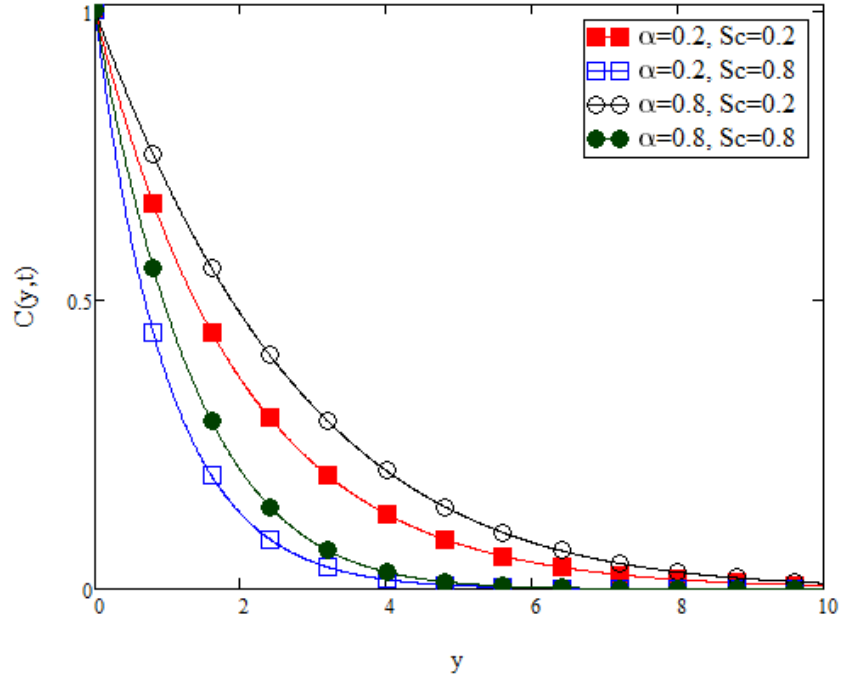
Figure 9. Variation in concentration profile due to variations in Sc and α